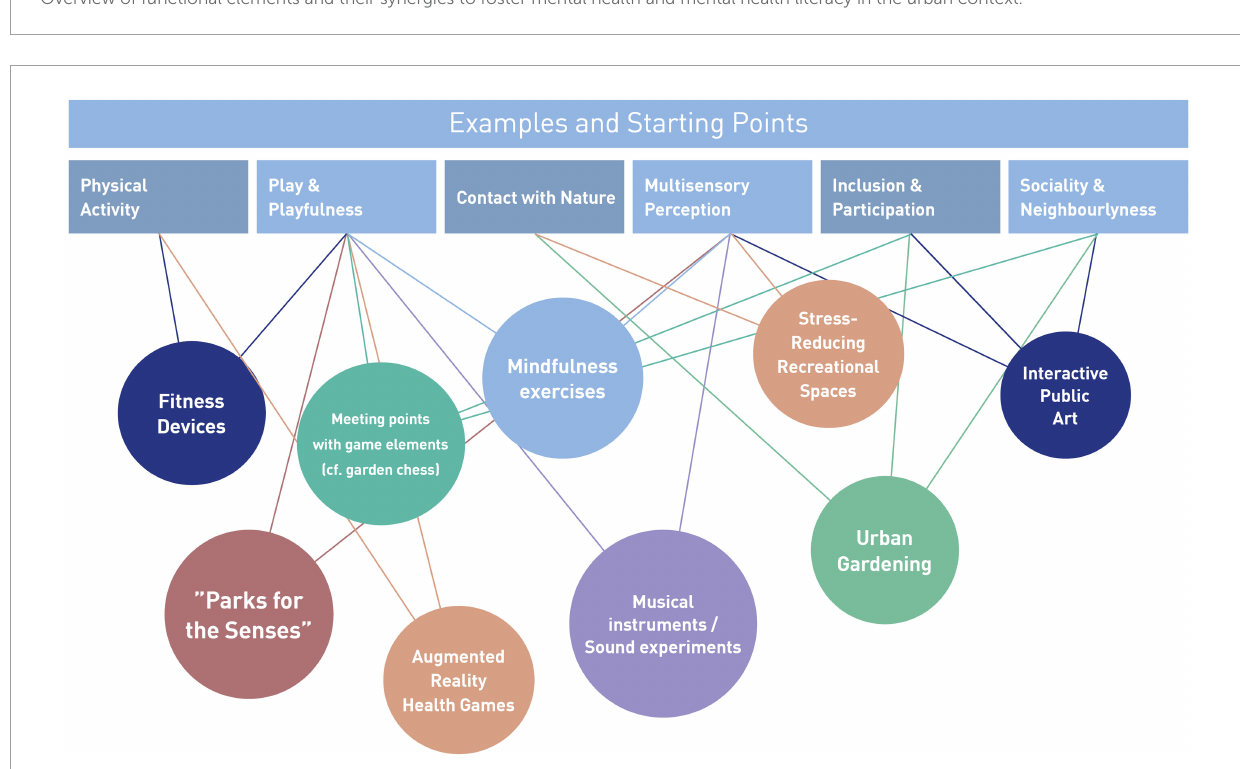
FIGURE1 Overview of functional elements and their synergies to foster mental health and mental health literacy in the urban context.